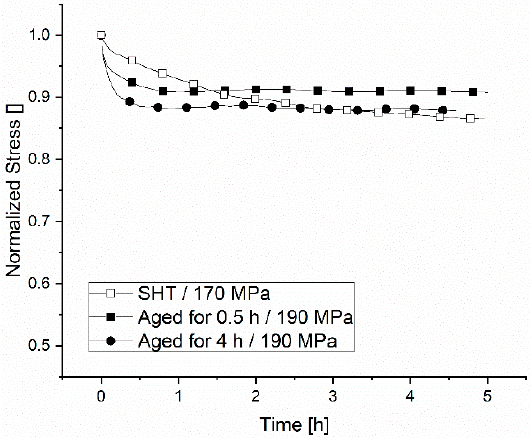
Figure 7. Normalized stress relaxation curves tested at 200 °C.